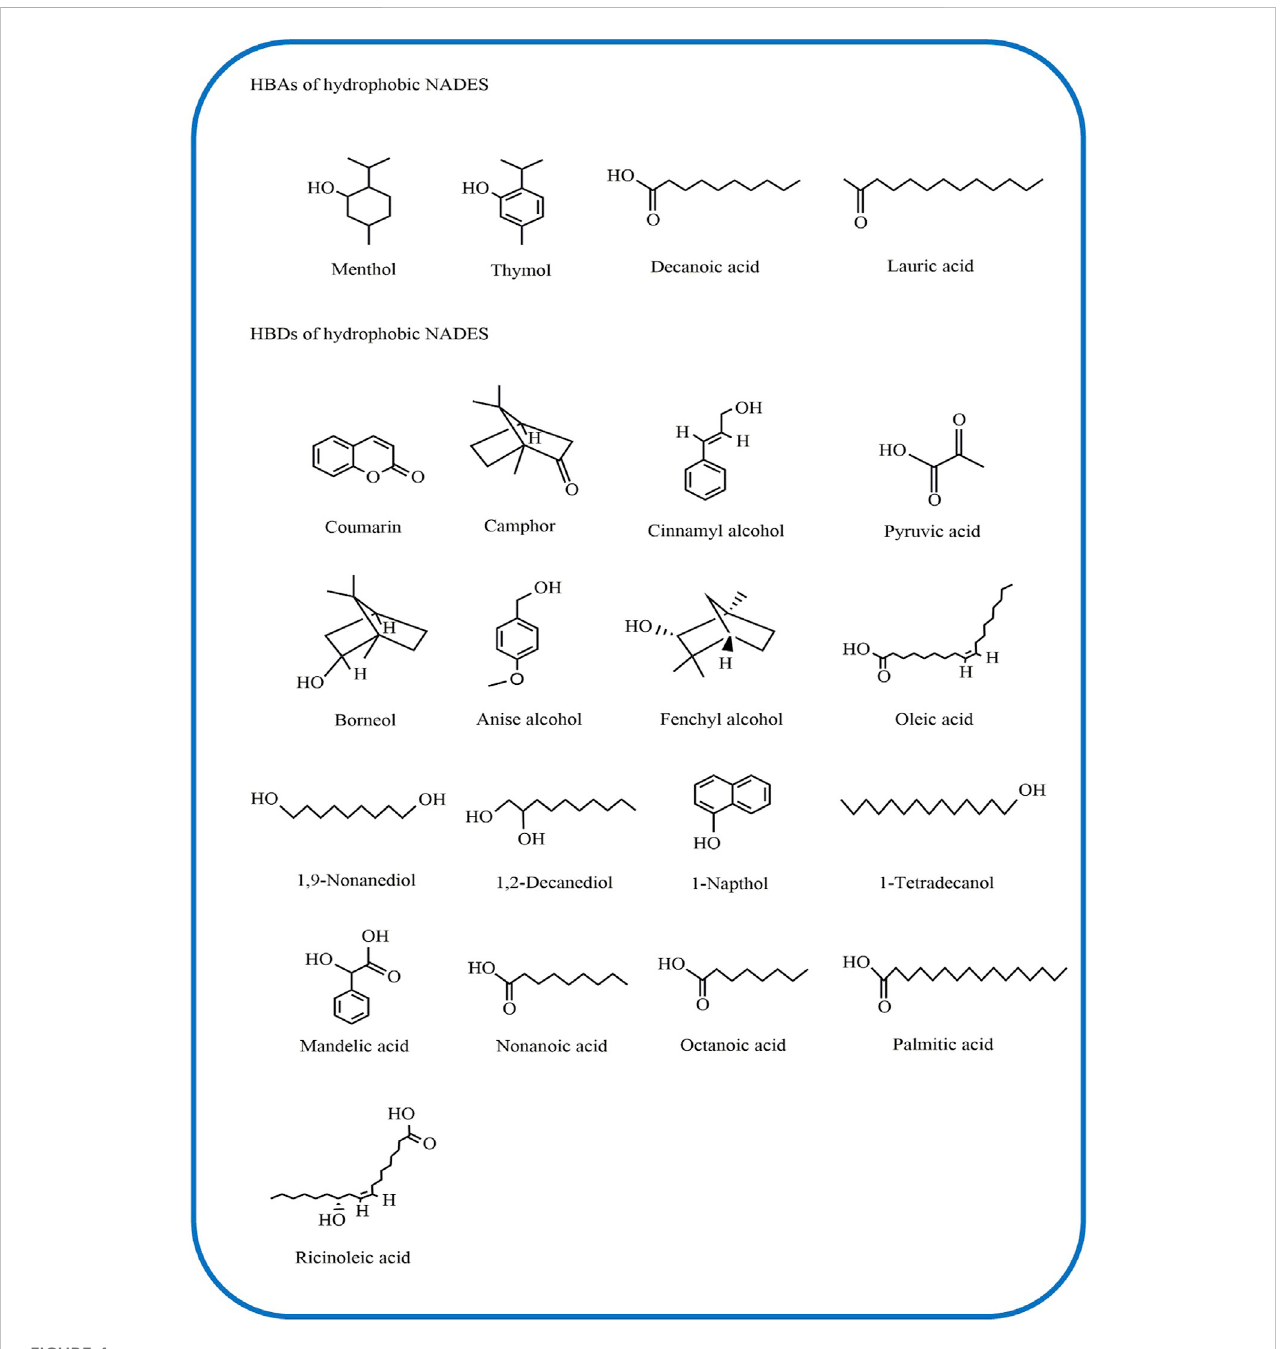
FIGURE 4 Common components of hydrophobic NADES. NADES, natural deep eutectic